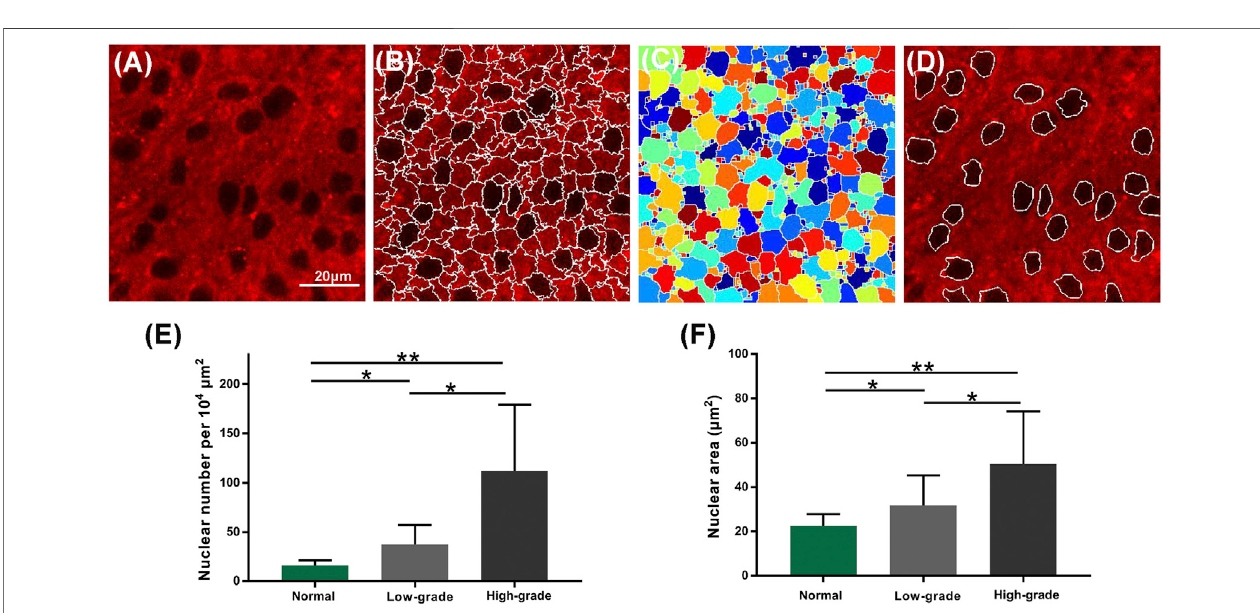
FIGURE 8 | Quantitative analysis of number and area of nuclei. (A – E) Representative nuclear segmentation results of the automated analysis algorithm: an original MPM image in a low-grade glioma (A) , the result after super-pixel segmentation and spectral clustering (B) , the result after watershed segmentation (C) , and the fi nal segmentation results (D) are displayed from left to right. (E) Number of nuclei of normal brain tissue, low-grade, and high-grade gliomas quanti fi ed using this algorithm. (F) Area of nuclei of normal brain, low-grade, and high-grade gliomas quanti fi ed using this